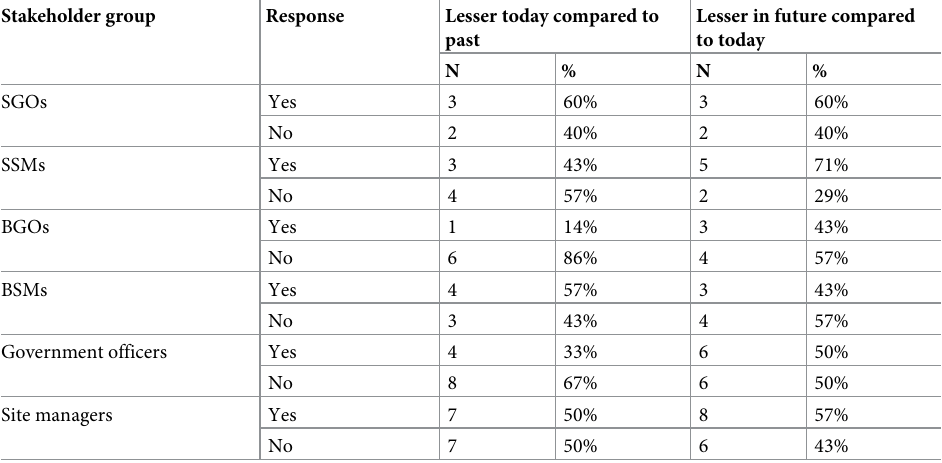
Table 6. Stakeholder attitudes towards property damage. Stakeholder